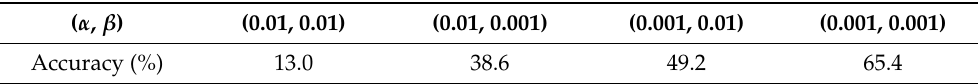
Table 6. Accuracy when applying DIPDefend to adversarial examples of (cid:101) = 2.